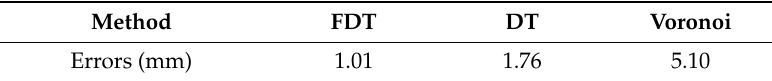
Figure 8. Distance measurement comparison. Table 1. Mean distance errors with three different